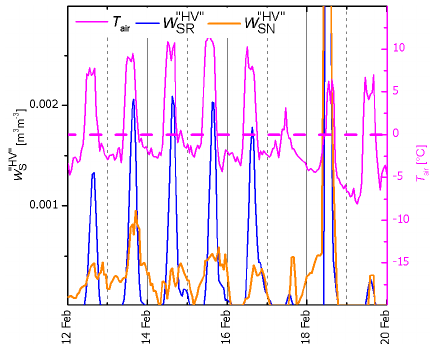
Figure 8. The orange line indicates (cid:1849) (cid:2903),(cid:2898)"(cid:2892)(cid:2906)" retrievals using (cid:1846) (cid:2886),(cid:2898)(cid:3043) ((cid:2016) (cid:3038) ) from 12–20 February. The blue and magenta lines show the (cid:1849) (cid:2903),(cid:2902)"(cid:2892)(cid:2906)" retrievals (Figure 5a) and the air temperature, respectively. It is evident that (cid:1849) (cid:2903),(cid:2898) "(cid:2892)(cid:2906)" retrievals and (cid:1849) (cid:2903),(cid:2902) "(cid:2892)(cid:2906)" “reference” retrievals are harmonized and undergo a similar diurnal variation pattern.